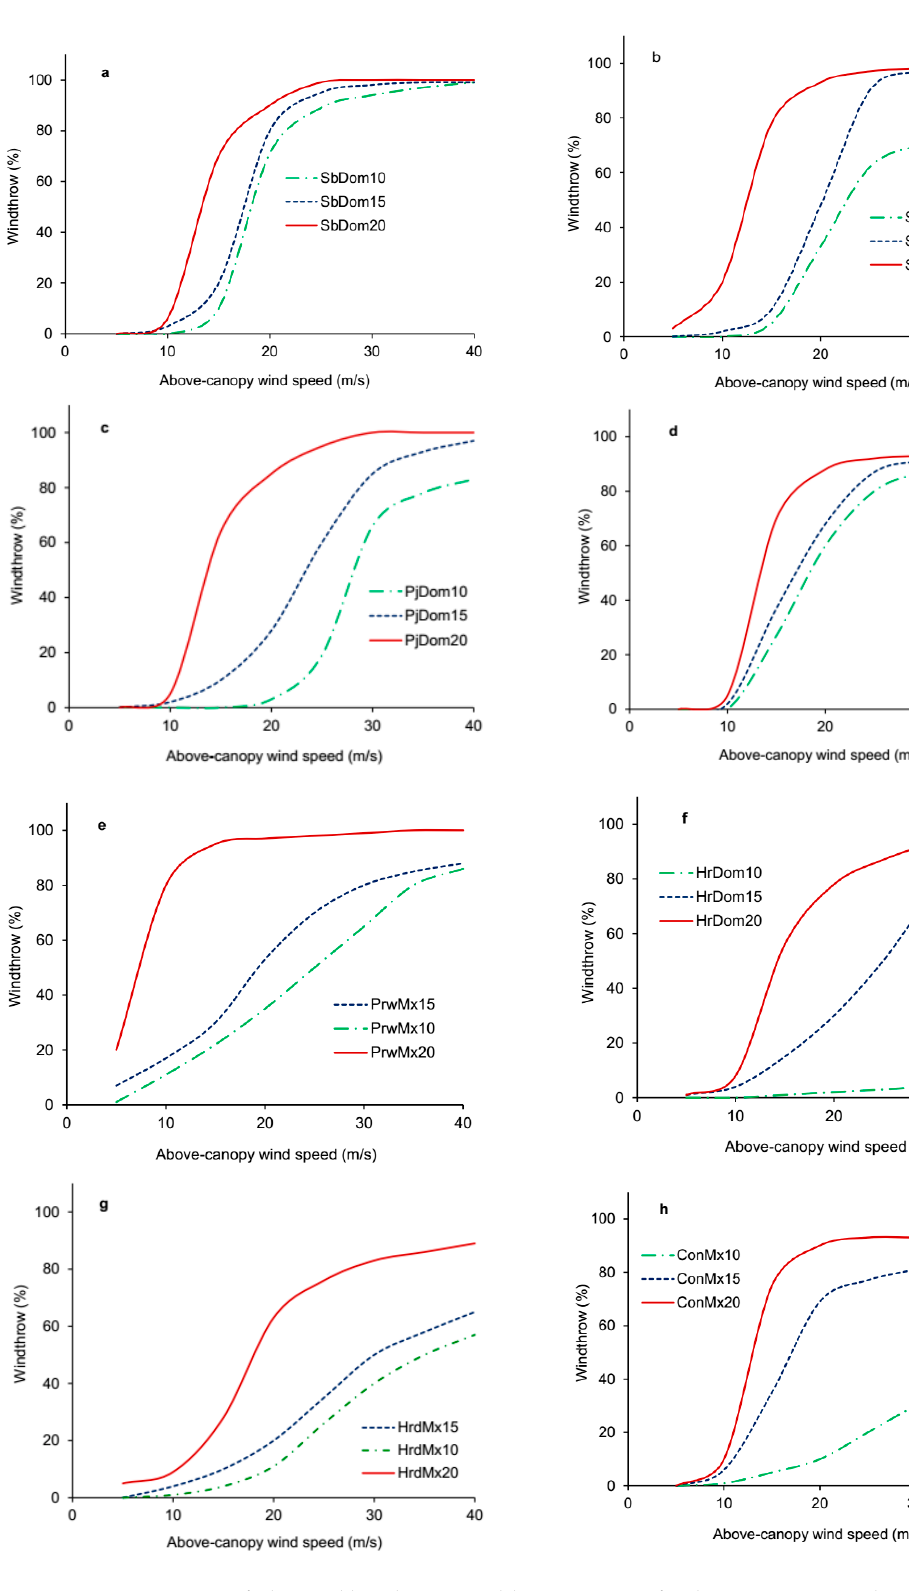
Figure 4. Proportion of plot total basal area windthrown at specific above-canopy wind speeds for the forest types: ( a ) spruce dominant; ( b ) spruce mixed stands; ( c ) Jack pine dominant; ( d ) Jack pine mixed; ( e ) Red and White pine mixed stands; ( f ) hardwood dominant stand type; ( g ) hardwood-mixed species stands; ( h ) Conifer mixed species stands, and by height class groups: 10 m, 15 m, and 20 m.